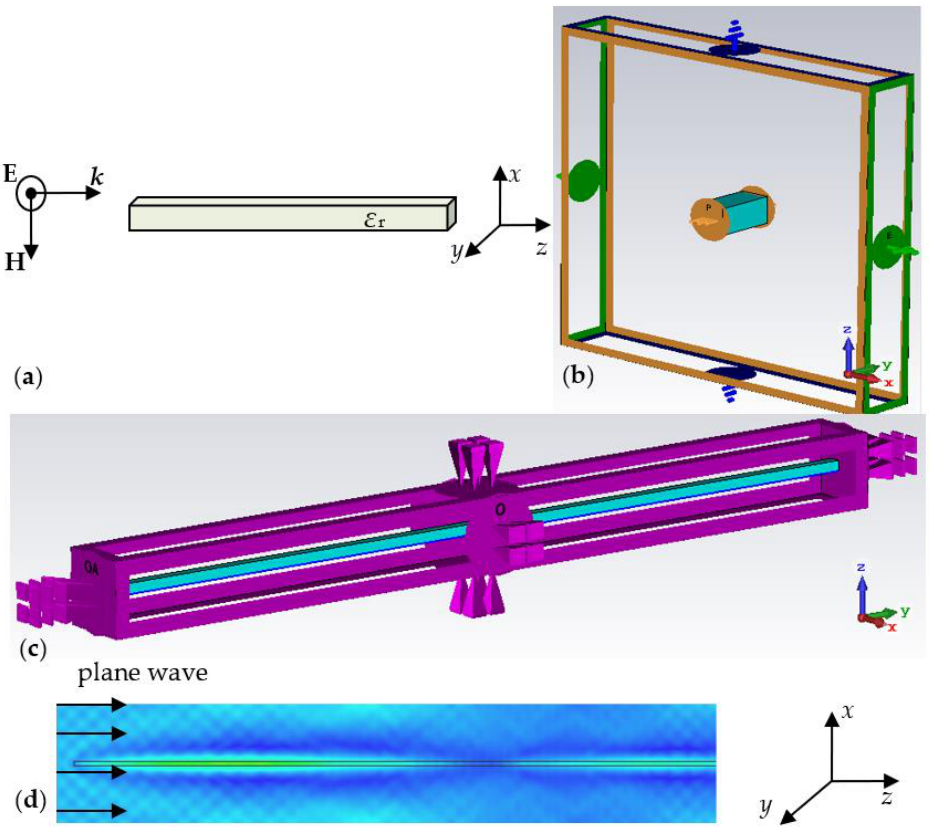
Figure 2. Schematic diagram of dielectric bar under plane-wave excitation ( a ), simulation model using CST Eigenmode Solver ( b ), simulation model using CST Time-Domain Solver ( c ) and Beat wave pattern along a dielectric bar simulated by CST Time-Domain Solver ( d ).